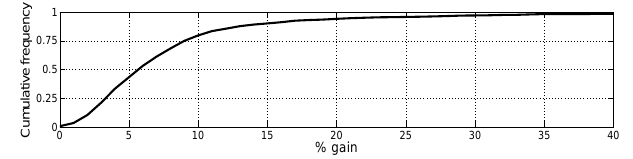
Fig. 11. Cumulative frequency of the CRPS gain after optimization.